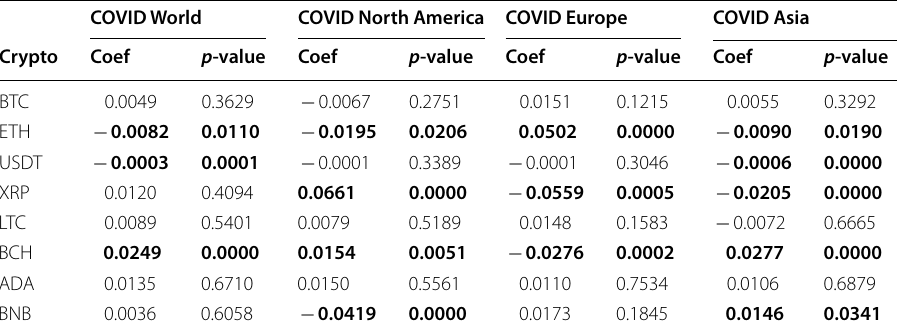
Table 4 CC price return strength models are explained by the variation in the effective reproductive